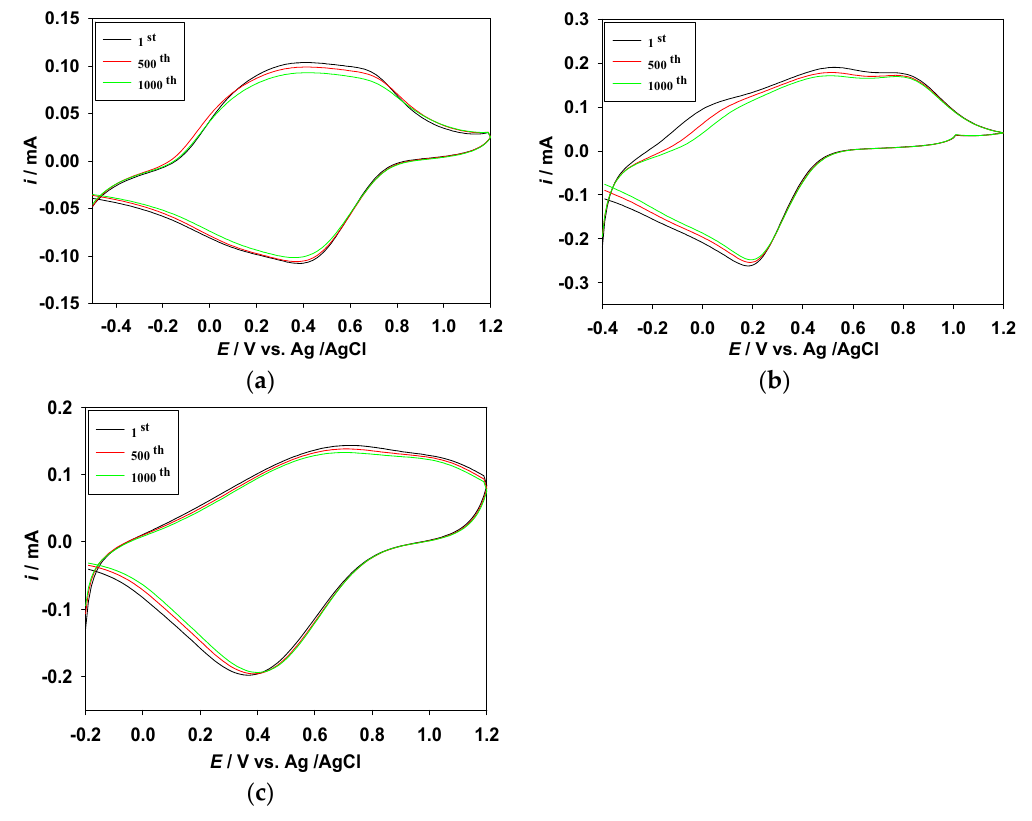
Figure 11. Cyclic voltammograms of ( a ) P(MPS- co -TTPA)/PProDOT-Et 2 ; ( b ) P(MPO- co -TTPA)/PProDOT-Et 2 ; and ( c ) P(ANIL- co -TTPA)/PProDOT-Et 2 ECDs as a function of repeated scans at 100 mV s –1 .